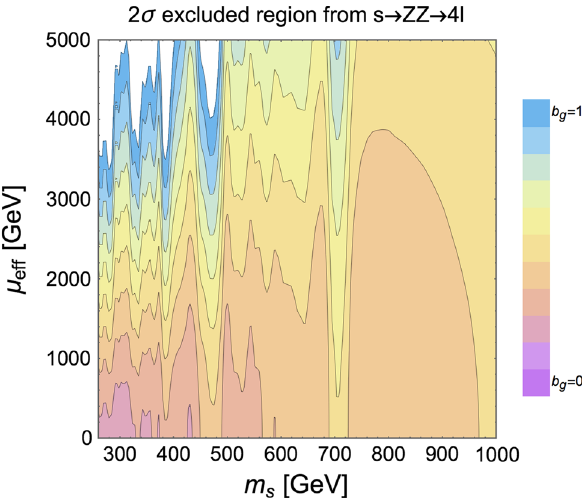
Fig. 6 The2 σ -excludedregionsfrom s → Z Z → 4 l boundinthe μ eff vs. m s plane. The color is changed in increments of 0.1. The weakest bound starts existing from b g = 0 . 2. K -factor is set to be K = 1 .